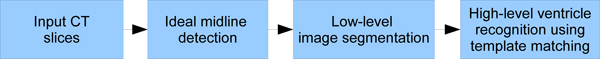
The framework of ventricle segmentation. This is the schematic description of our method. First ideal midline is detected and used to align CT scans in the same direction. Then low-level segmentation and high-level recognition are applied.